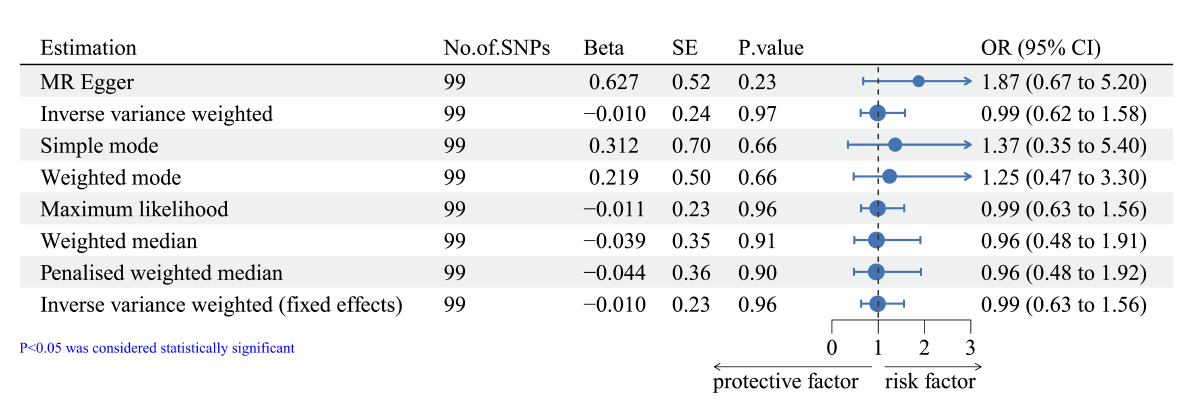
FIGURE 3 Forest plot of MR methods of the effect of telomere length on the prognosis of ER+ breast cancer. MR, Mendelian